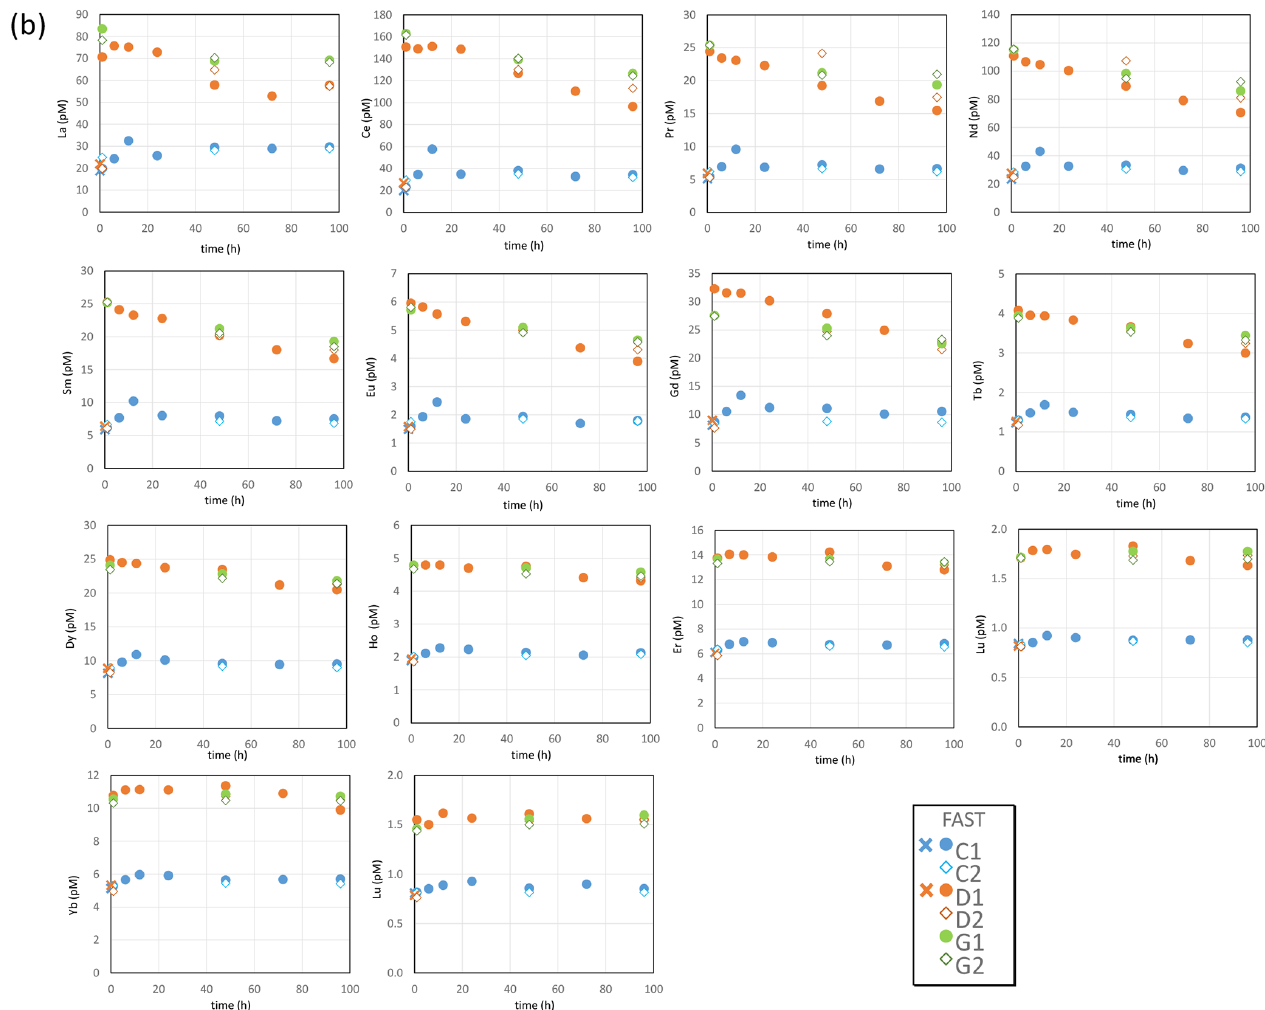
Figure 2. Concentrations of dissolved REEs during the tank experiments at (a) ION station and (b) FAST station. Crosses correspond to samples collected before dust addition ( t =